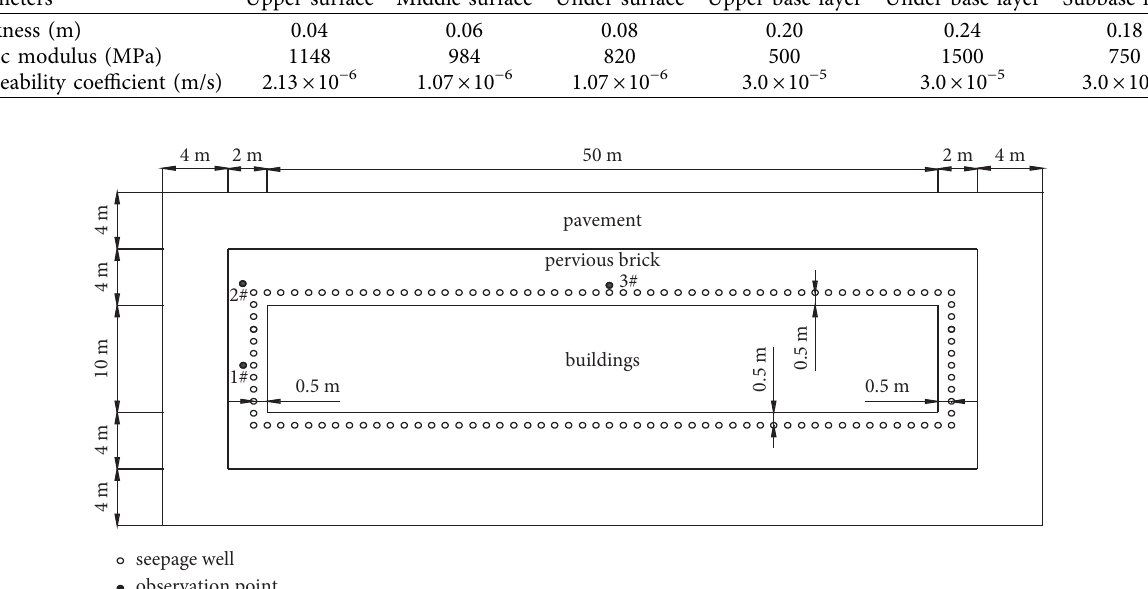
Figure 14: Diagram of a single building and surrounding road with seepage wells in the numerical model.